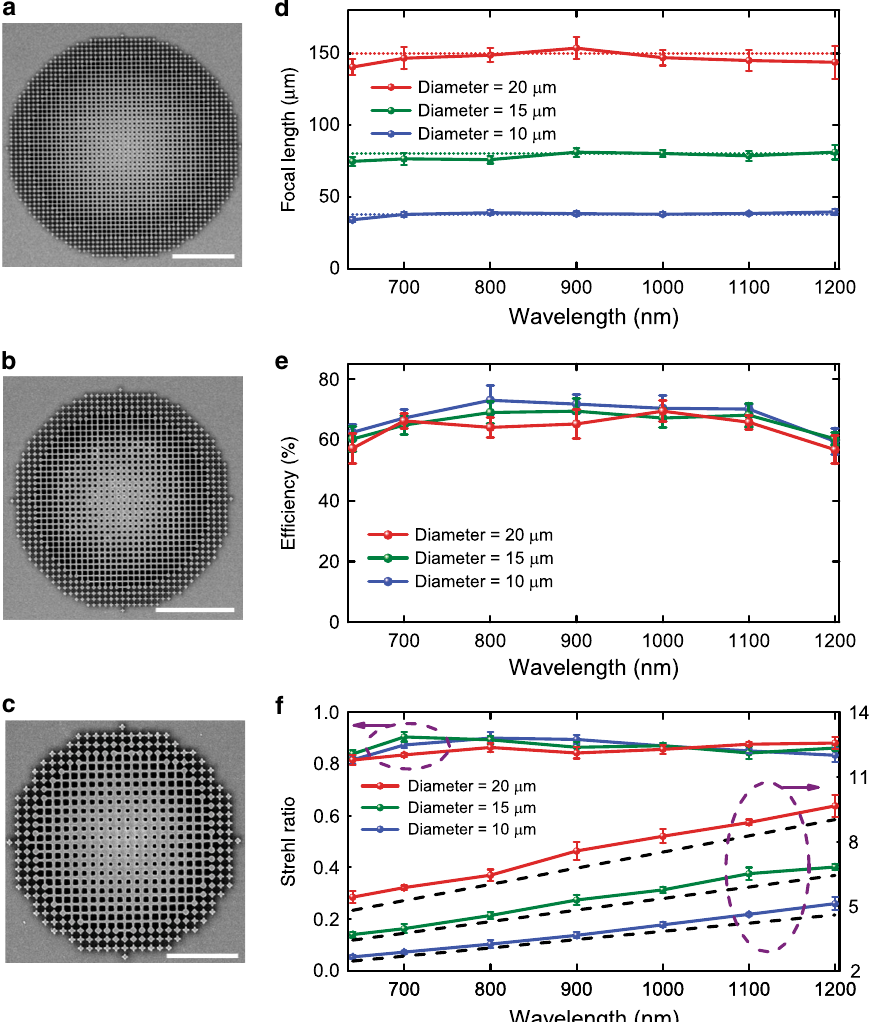
Fig. 4 Measured performance of various FAMs. SEM of metalenses of diameter 20 µ m a , 15 µ m b , and 10 µ m c . The scale bars in a – c represent 5, 5, and 3 µ m, respectively. d Comparison of the measured and designed focal lengths for metalenses of various sizes. e Focusing ef fi ciency and the measured average ef fi ciency is about 70% in the band from 640 to 1200 nm. The measured ef fi ciency of a FAM is de fi ned as the power at the focal spot divided by the power transmitted through an aperture of the same diameter as the FAM. f FWHM at corresponding focal planes as a function of the wavelength (right axis) and measured Strehl ratios (left axis) of the FAMs. Results indicate that FAMs enable diffraction-limited focusing. Error bars are the standard deviation of measurements on